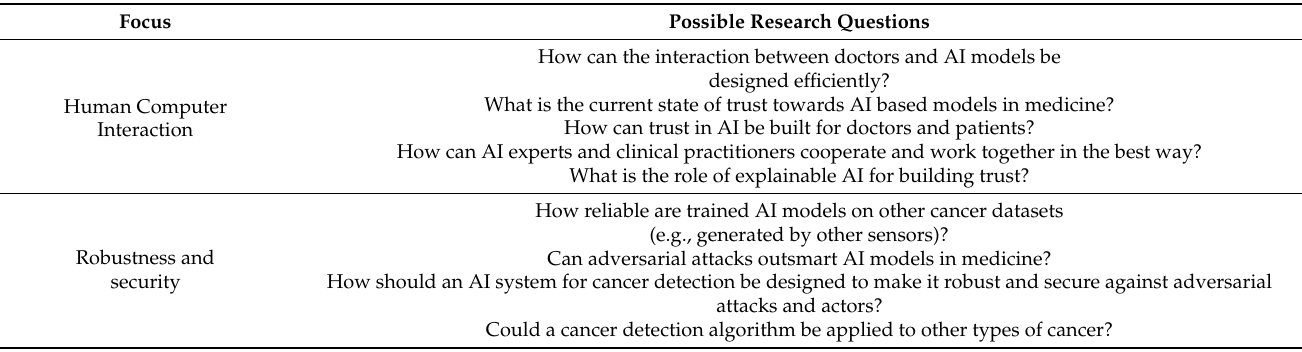
Table 9. Future research